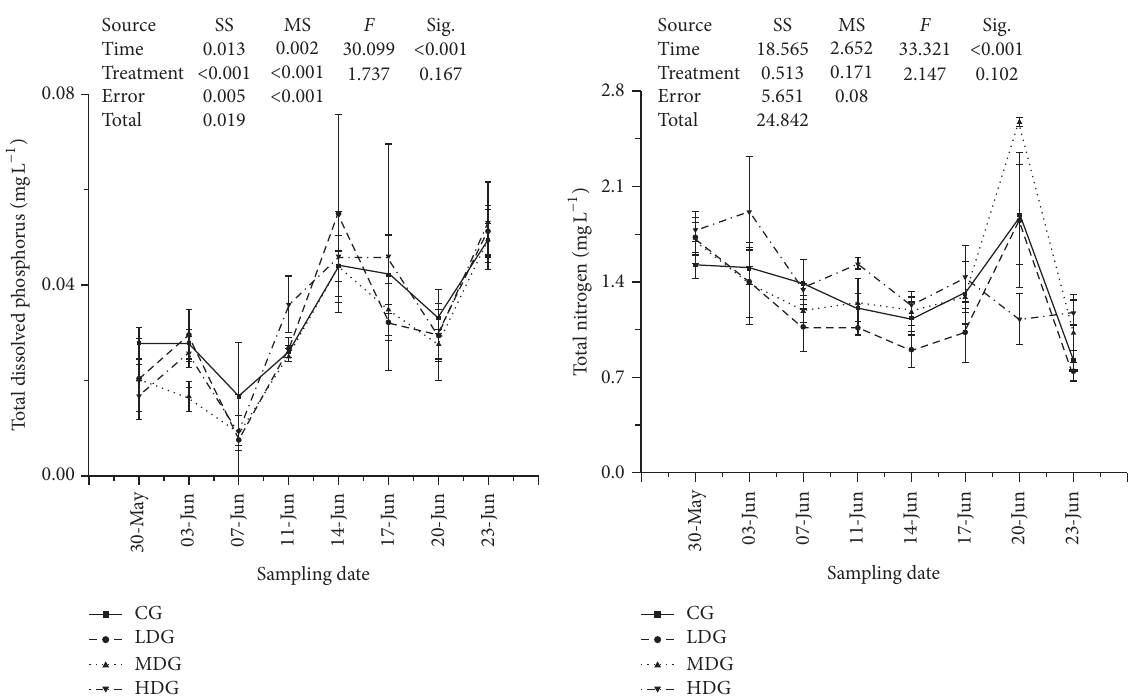
Figure 4: Nutrients values including total dissolved phosphorus and total nitrogen in each enclosure treatment during sampling points. Values were presented by mean ± STDEV. No significant differences between each other and parameters in each treatment. SS: type III sum of squares, df: freedom, and MS: mean square.